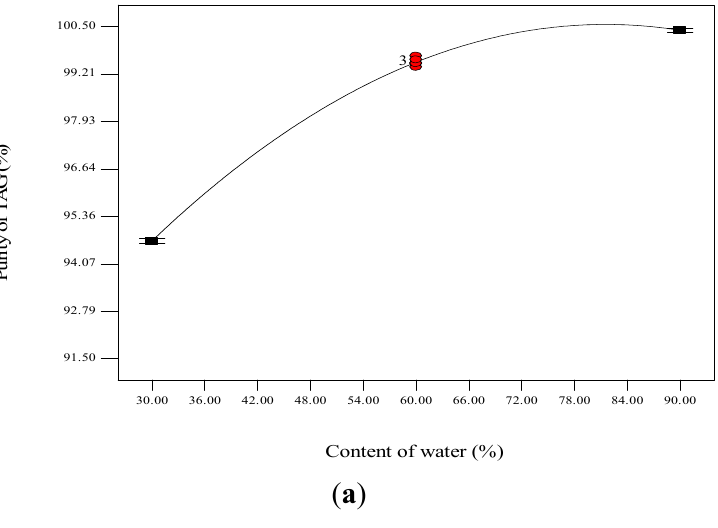
Figure 2. Main effect plot showing the effect of water content ( a ), pH ( b ) and temperature (°C) on TAG